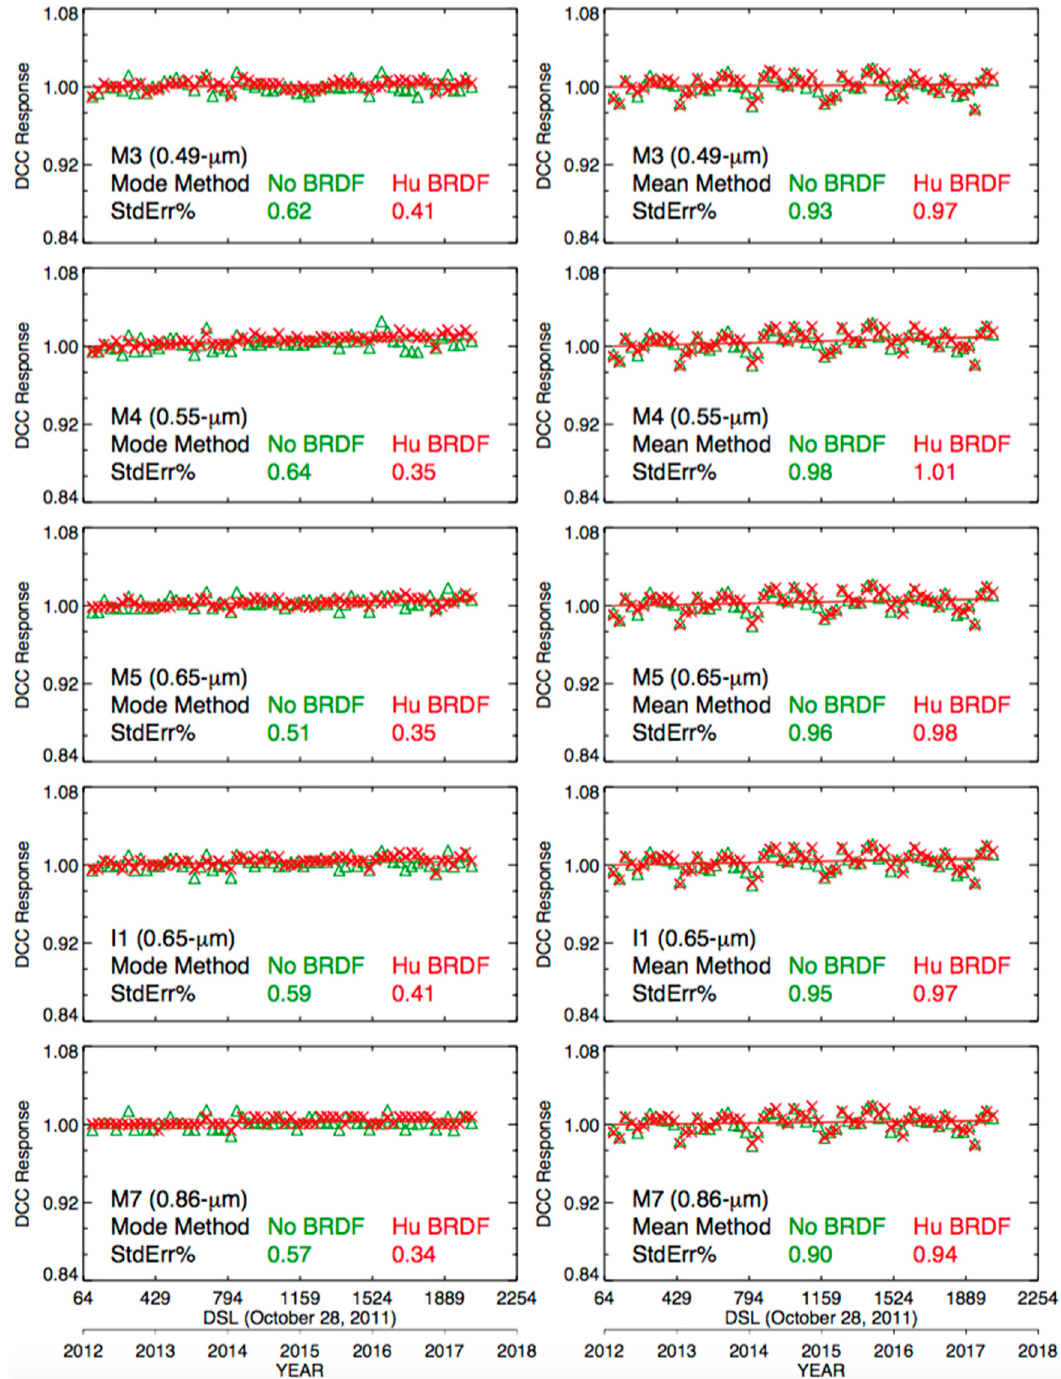
Figure 2. The normalized DCC Mode ( left ); and Mean ( right ) reflectance time series with ( red “×”) and without ( green “ Δ ”) Hu anisotropic corrections for VIIRS VIS and NIR bands, with corresponding linear trend line and standard error in percent.